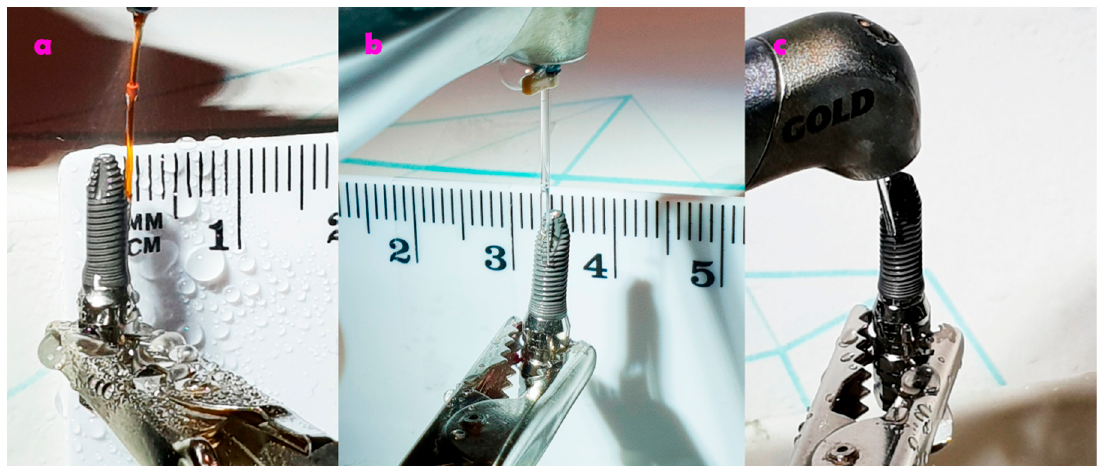
Figure 1. Protocol of irradiation. ( a ) Conical type of 415 micrometer (RTF3-17 mm) tip; ( b ) 800